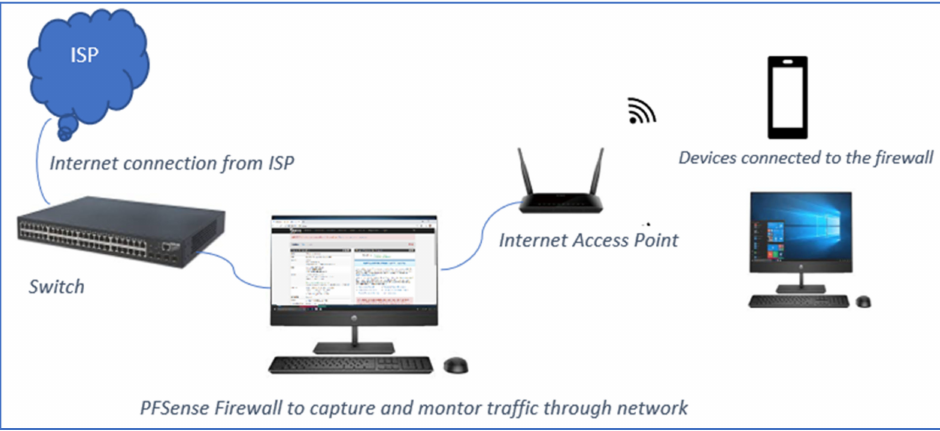
Figure 2. Experimental setup for capturing the network encrypted traffic of Signal app.